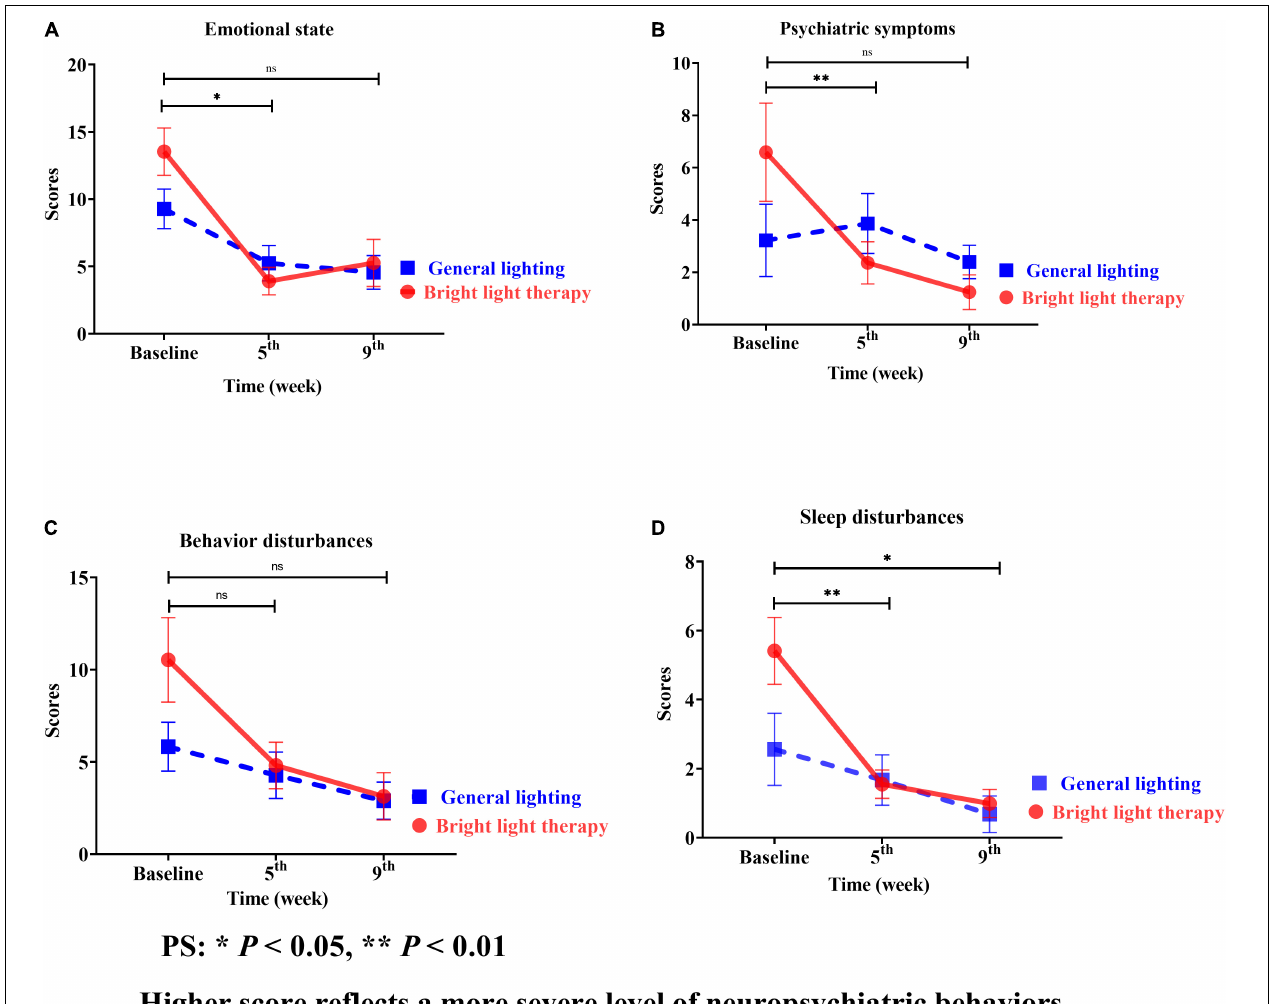
FIGURE 5 | (A) Emotional state, (B) psychiatric symptoms, (C) behavioral disturbances, and (D) sleep disturbances of the two groups at different time points; for both the experimental and comparison groups, the domain with the maximum change was psychiatric symptoms. However, the change was not statistically significant (B) . Continuous promising improvements were observed in sleep disturbances (D) . The experimental group showed a significant improvement in sleep disturbances (Wald’s test = 3.9, P < 0.002; Wald’s test = 10.0, P = 0.04) from baseline to the 5th and 9th weeks compared with the comparison